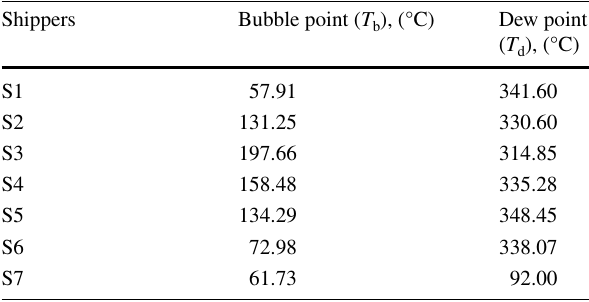
Table 12 Normal bubble and dew points of crude oils